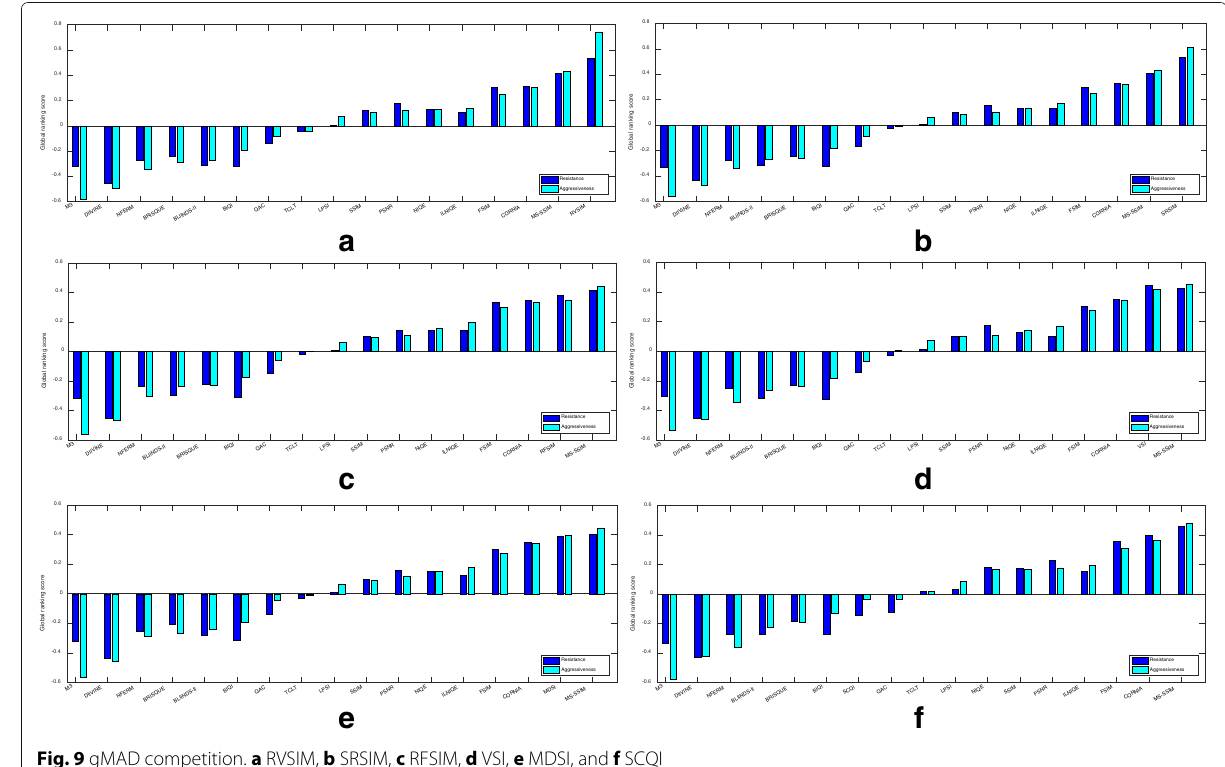
Fig. 9 gMAD competition. a RVSIM, b SRSIM, c RFSIM, d VSI, e MDSI, and f SCQI